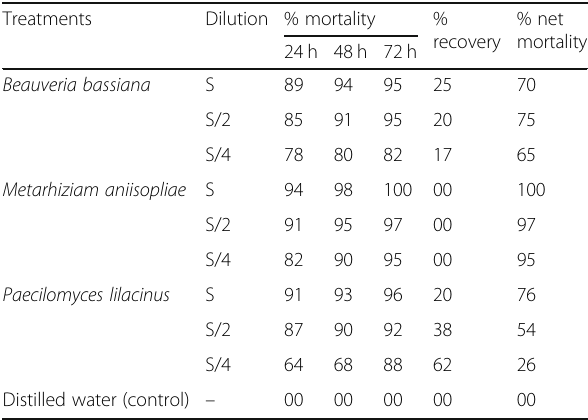
Table 3 Effects of three culture filtrate dilutions from Beauveria bassiana , Metarhiziam aniisopliae and Paecilomyces lilacinus on the mortality of second-stage juveniles of Meloidogyne incognita under in vitro